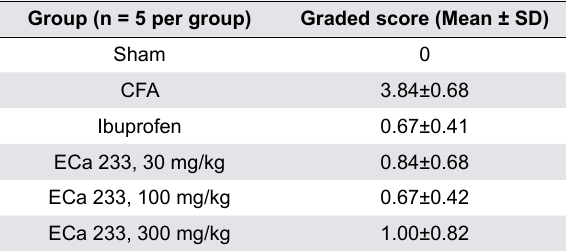
Table 2- Graded scores of the temporomandibular joint osteoarthritis in the different groups after ECa 233